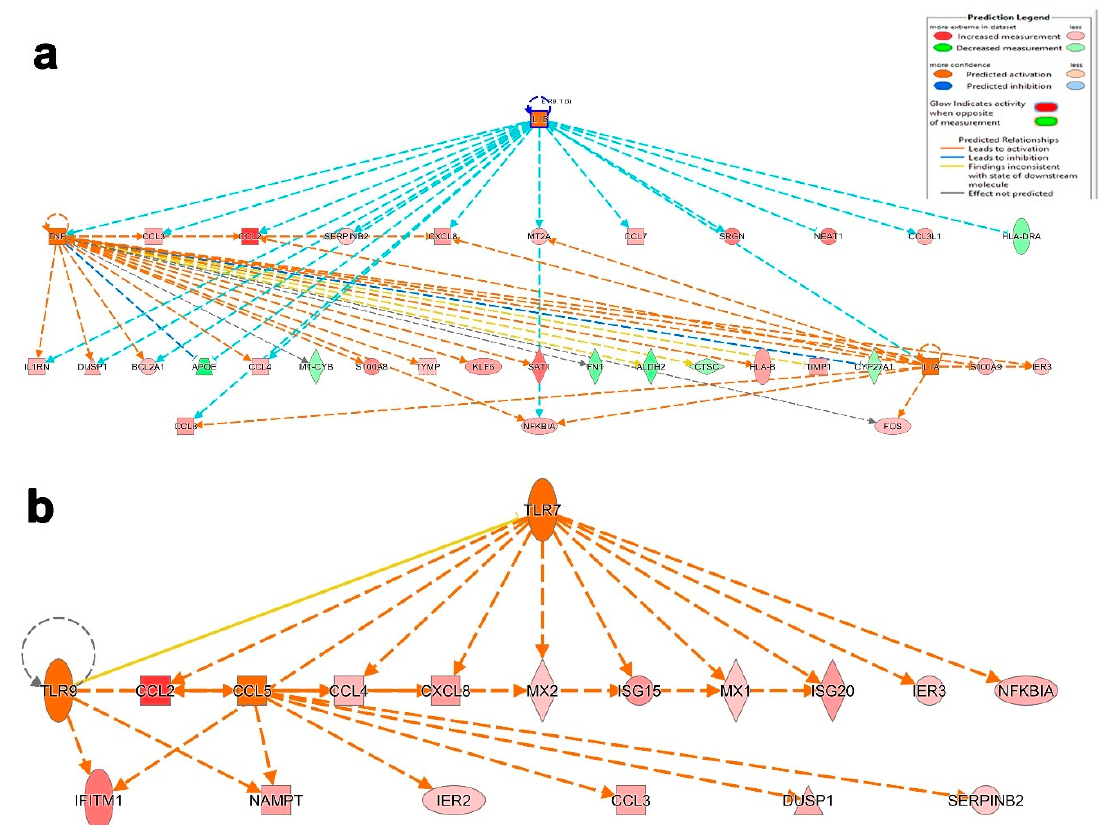
Figure 7. Illustration of selected activated upstream networks in patients with severe COVID-19. Graphical presentation of IL1A, IL1B, and TNF ( a ) networks in patients with severe COVID-19. ( b ) Presentation of CCL5, TLR7, and TLR9 upstream regulator networks.